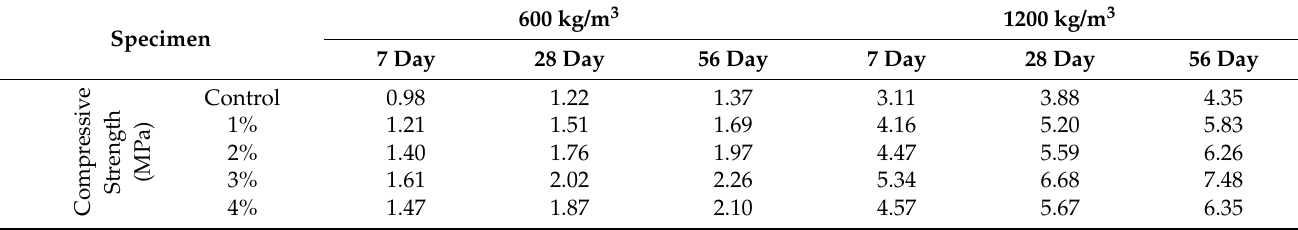
Table A1. Compressive, flexural, and splitting tensile strengths experimental